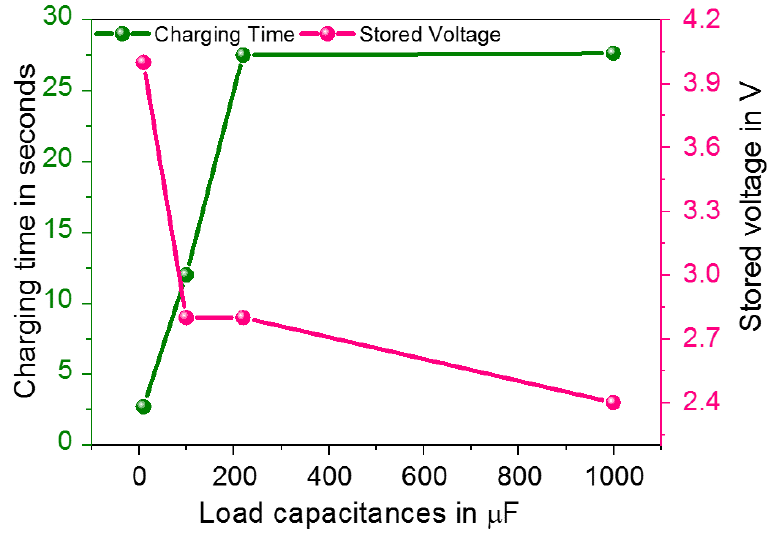
Figure 15. DC Voltage stored and related charging time versus load